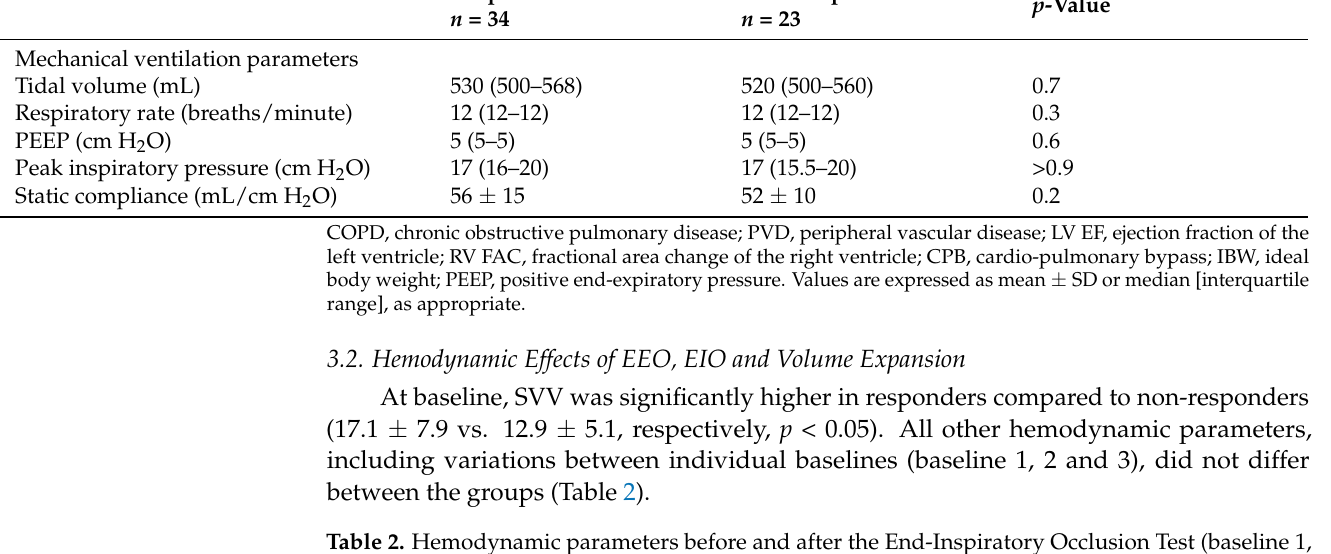
Table 2. Hemodynamic parameters before and after the End-Inspiratory Occlusion Test (baseline 1, EIO), before and after the End-Expiratory Occlusion Test (baseline 2, EEO) and before and after a fluid challenge (baseline 3,